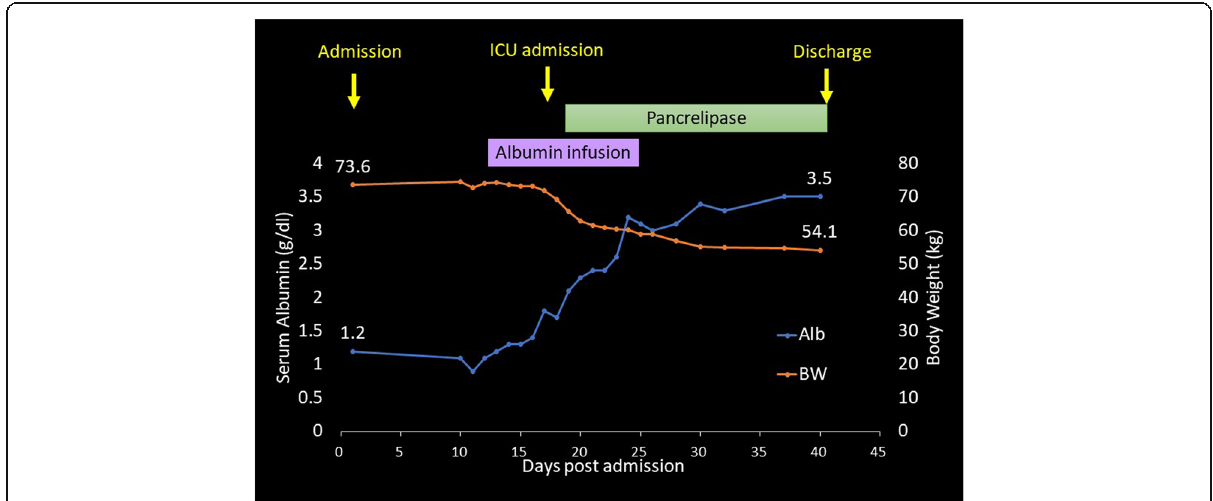
Fig. 3 Clinical course with transitional changes in the serum albumin level and body